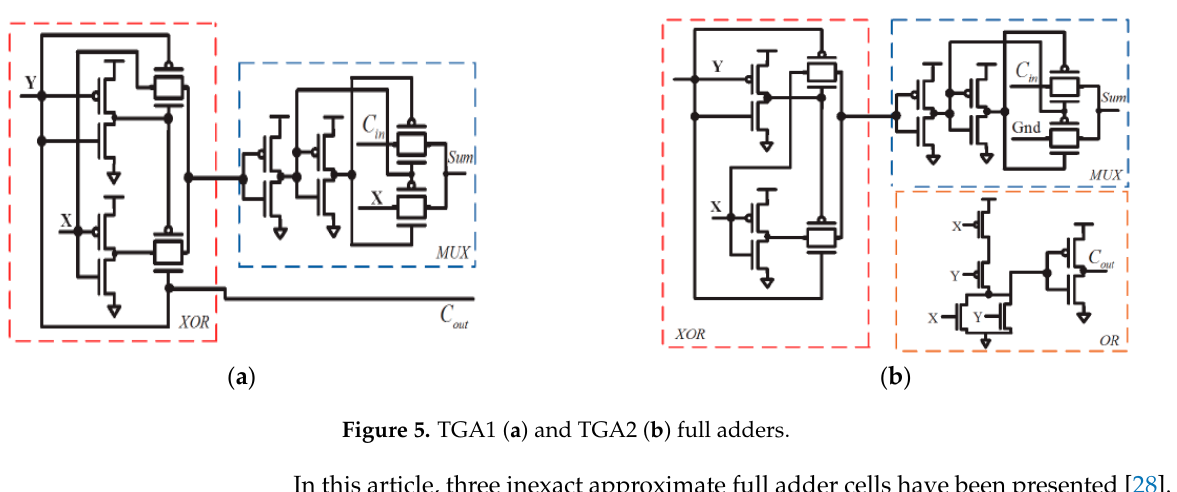
Figure 5. TGA1 ( a ) and TGA2 ( b ) full adders. In this article, three inexact approximate full adder cells have been presented [28]. The inexact full adder design comprises of NAND, XOR, and inverter logic gates [29,30]. These cells exhibit error and electrical characteristics and are useful in approximate com- puting. The first inexact adder cell consists of three inputs known as X, Y, and Ci and two outputs which are sum and carry. At the level of the transistor, the first cell has two n- type and four p-type transistors. The second and third inexact adder cells have eight and six transistors. At the output level, the carry output displays two errors. The second and